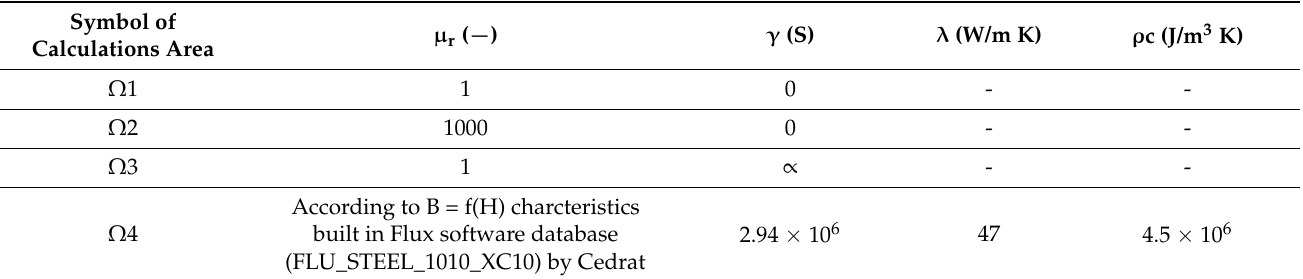
Table 1. Physical properties of modelled areas.